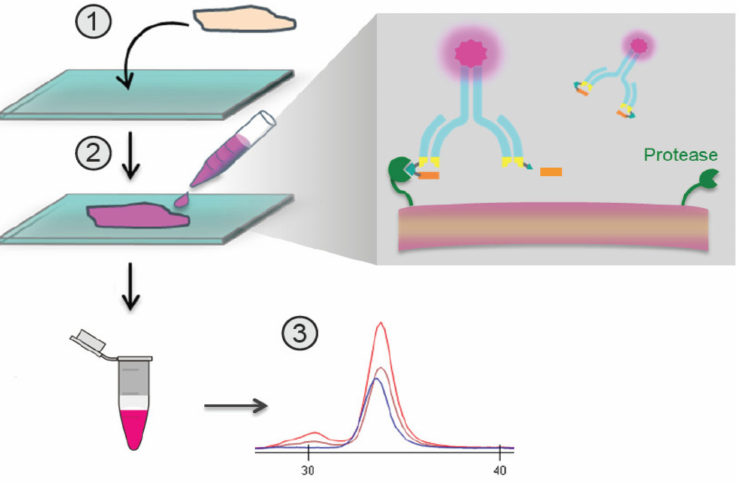
Figure 1. Overview of the in situ quantitative zymography (QZ) assay. Schematic demonstrating QZ methodology for the assessment of in situ Probody therapeutic(s) (Pb-Tx) activation. Labeled Pb-Tx are incubated with a tissue section, and the extent of Pb-Tx activation is measured in conditioned medium using capillary electrophoresis